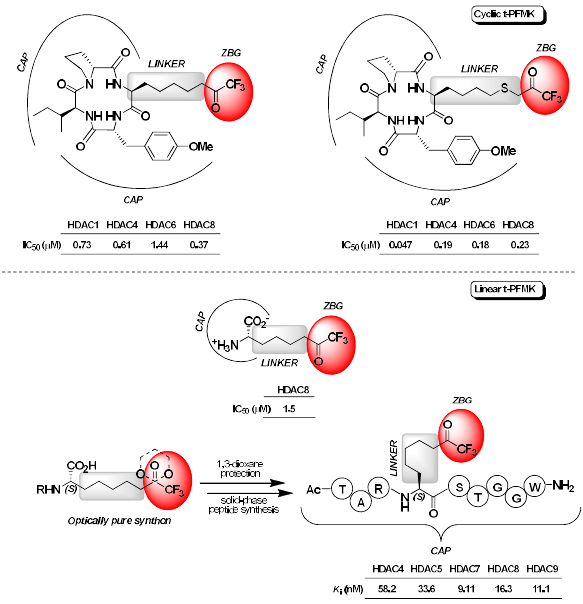
Figure 17. Structures and activity of the t-PFMKs developed as HDAC inhibitors.